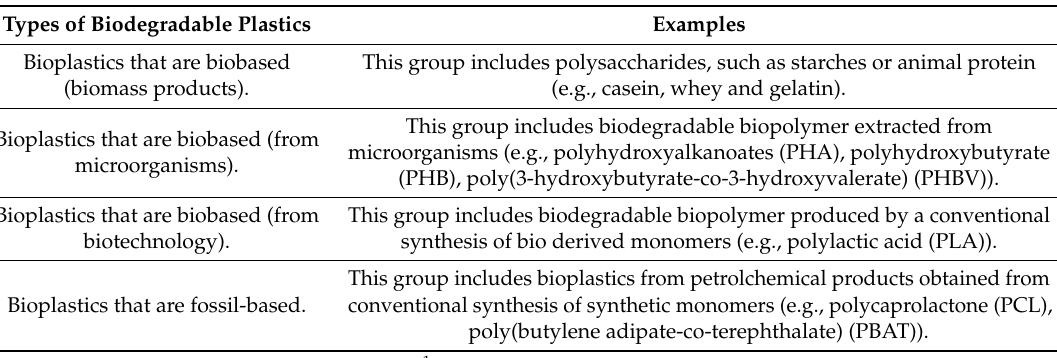
Table 1. Classification of biodegradable types of plastics 1